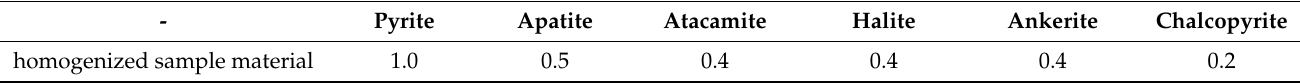
Table 3. Trace minerals in the homogeneous sample material (coarse- and